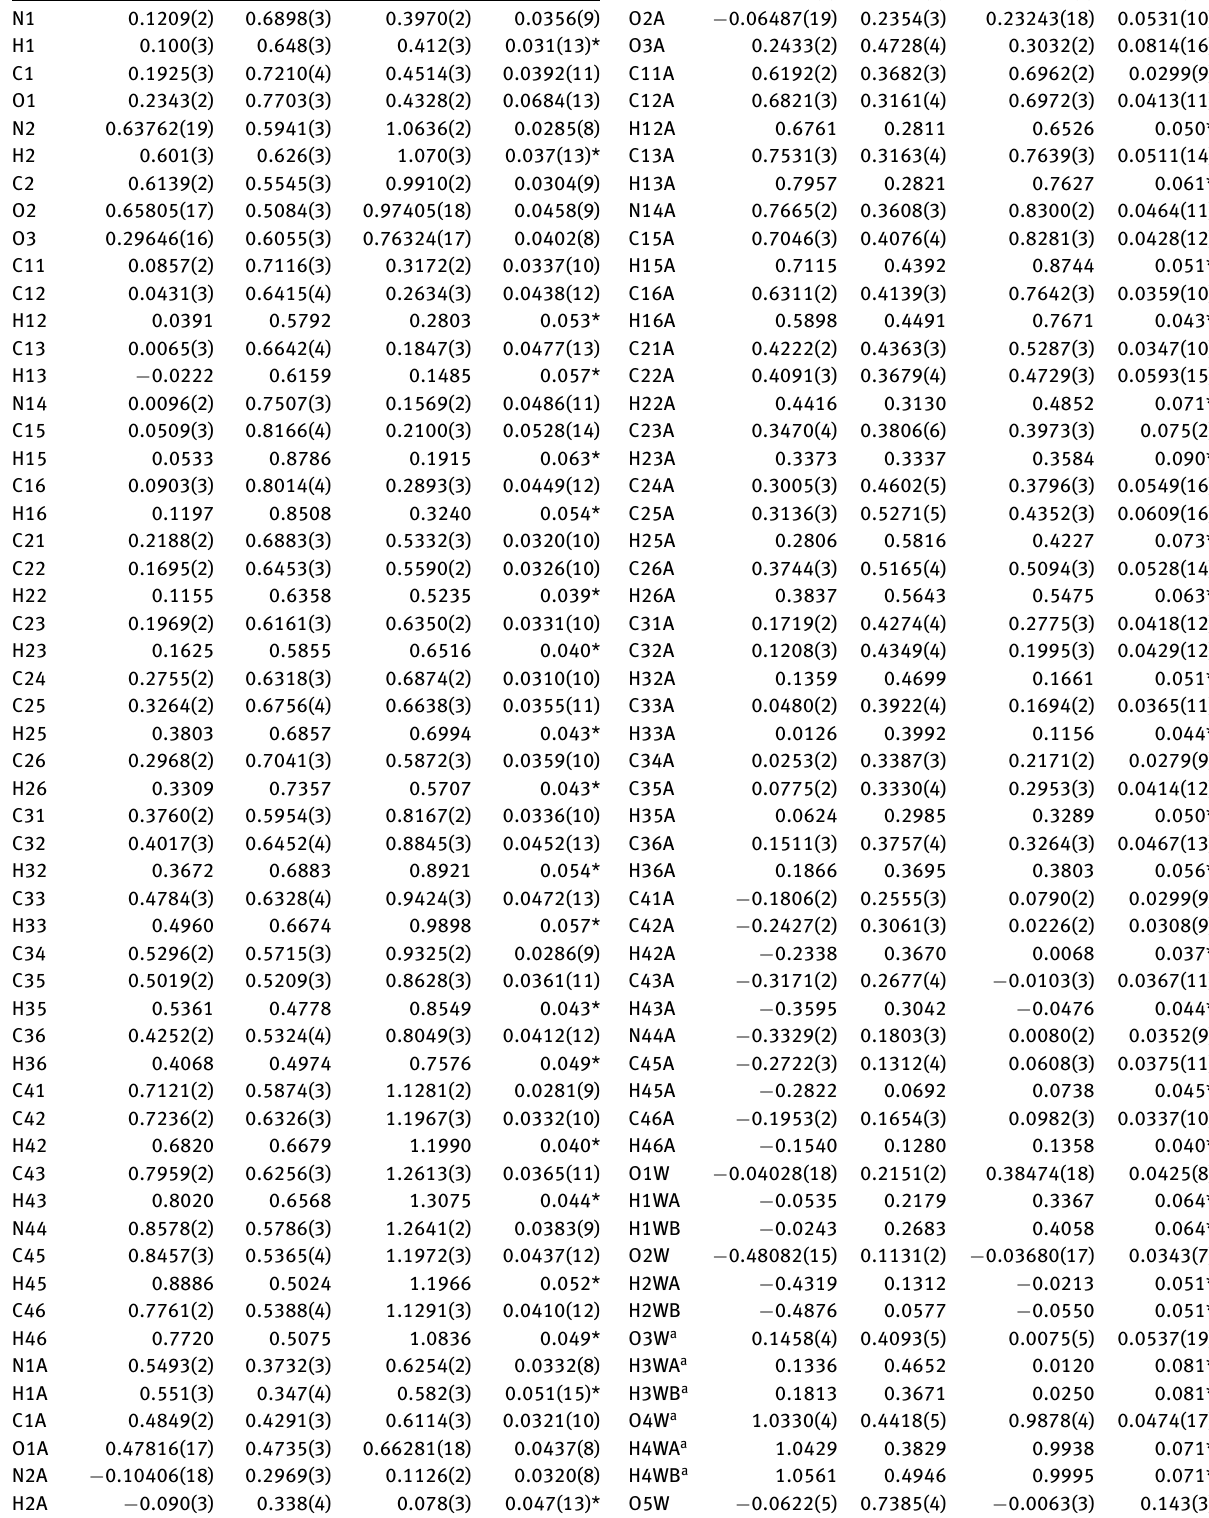
Table 2: Fractional atomic coordinates and isotropic or equivalent isotropic displacement parameters (Å 2